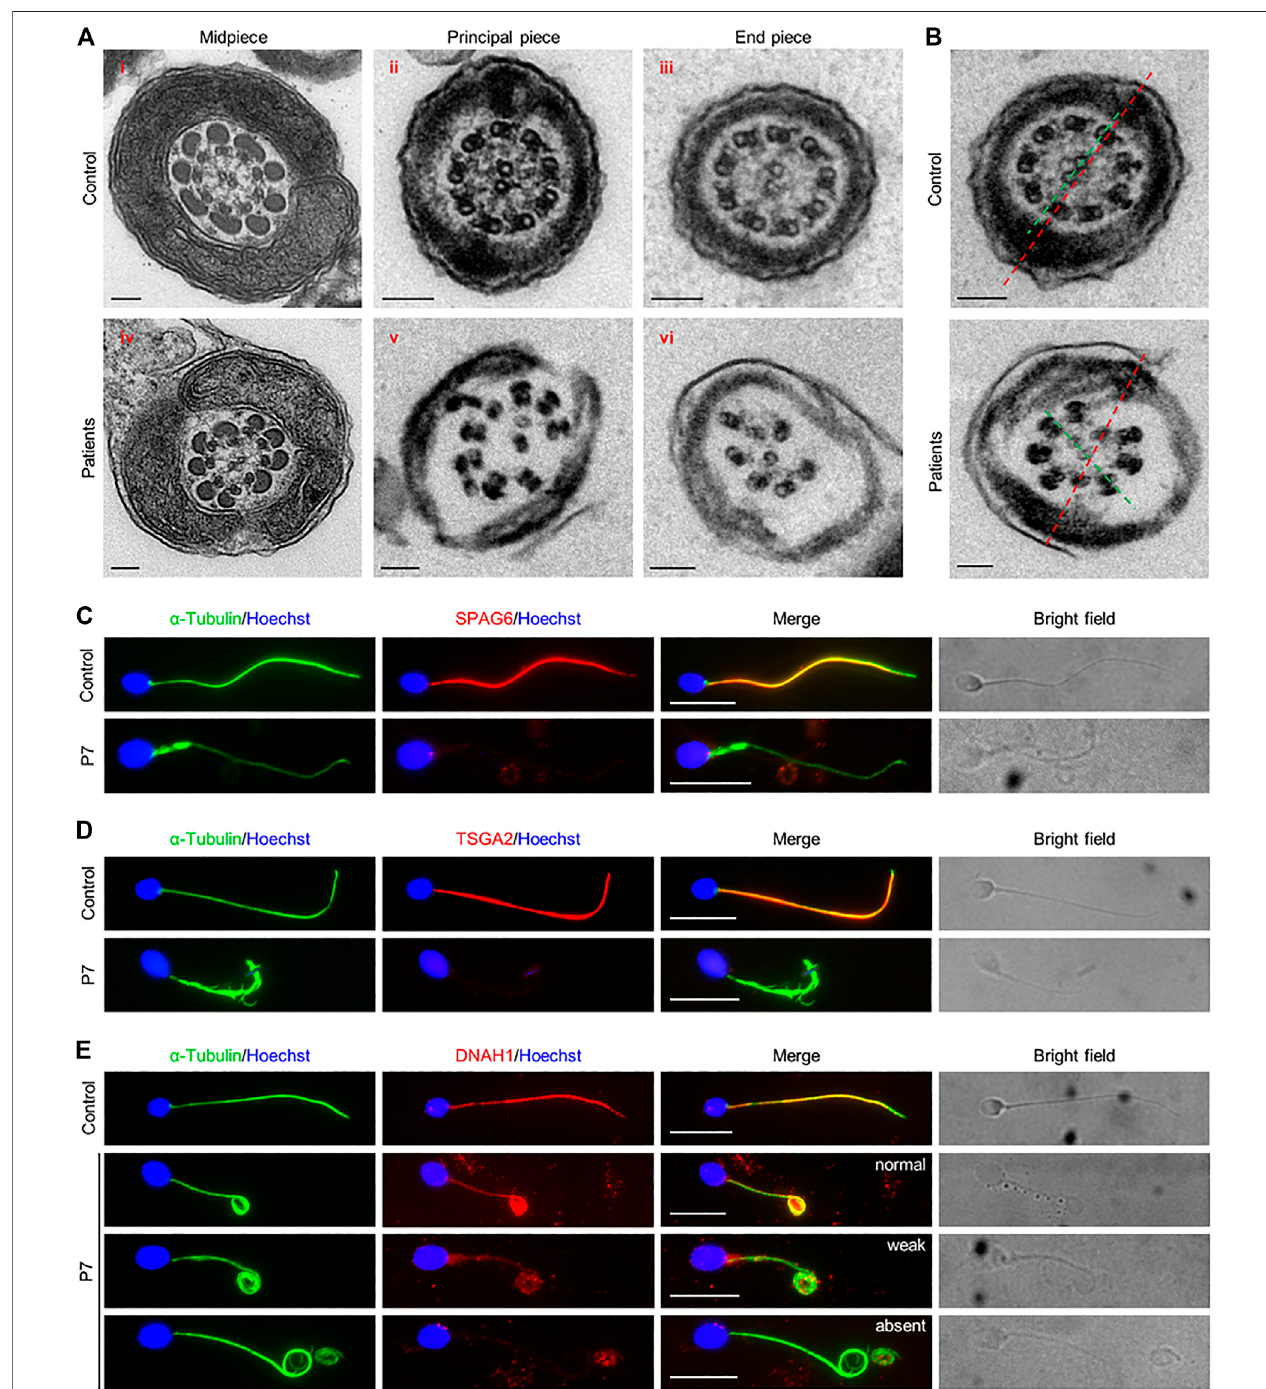
FIGURE2| Ultrastructural fl agellarabnormalitiesand fl agellarproteindefectsinpatients. (A) RepresentativeTEMmicrographsshowingcrosssectionsofmidpiece (i and iv),principalpiece (iiand v), and end piece (iiiand vi),ofsperm fl agella from afertile controland patients.Scale bars represent100 nm. (B) Cross-sections showing the rotated central pairs (CPs) from patients. Red dash lines represent the expected direction of CPs, predicted from the position of longitudinal columns. Green dash lines show the observed direction of CPs, which has an angle with the expected direction (red dash line) in patients. (C – E) Representative images of spermatozoa from a fertile control and P7 co-stained by anti- α -Tubulin antibodies and anti-SPAG6 antibodies (C) , anti-TSGA2 antibodies (D) , or anti-DNAH1 antibodies (E) . Representative fl agella with relatively normal, weak, or absent DNAH1 signals in spermatozoa from P7 were shown in (E) . Scale bars represent 10 μ m.